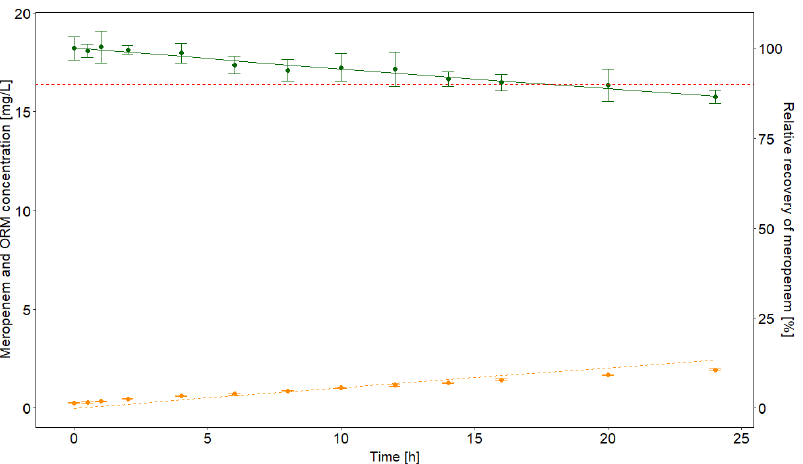
Figure 1. Degradation of 2% meropenem in vitro in normal saline infusate at 22 °C. Red dashed line: 90% relative recovery of meropenem. Green dots: mean measured concentrations of meropenem. Orange dots: mean measured concentrations of the open-ring metabolite (ORM). Standard deviations are depicted with error bars. The non-linear degradation is shown by the green line, while the orange dotted line indicates the theoretical increase in ORM, which is not entirely